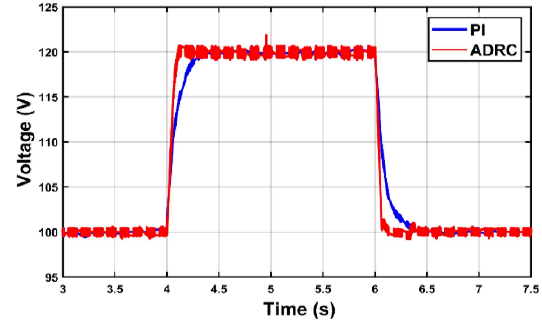
Figure 11. Output voltage responses.